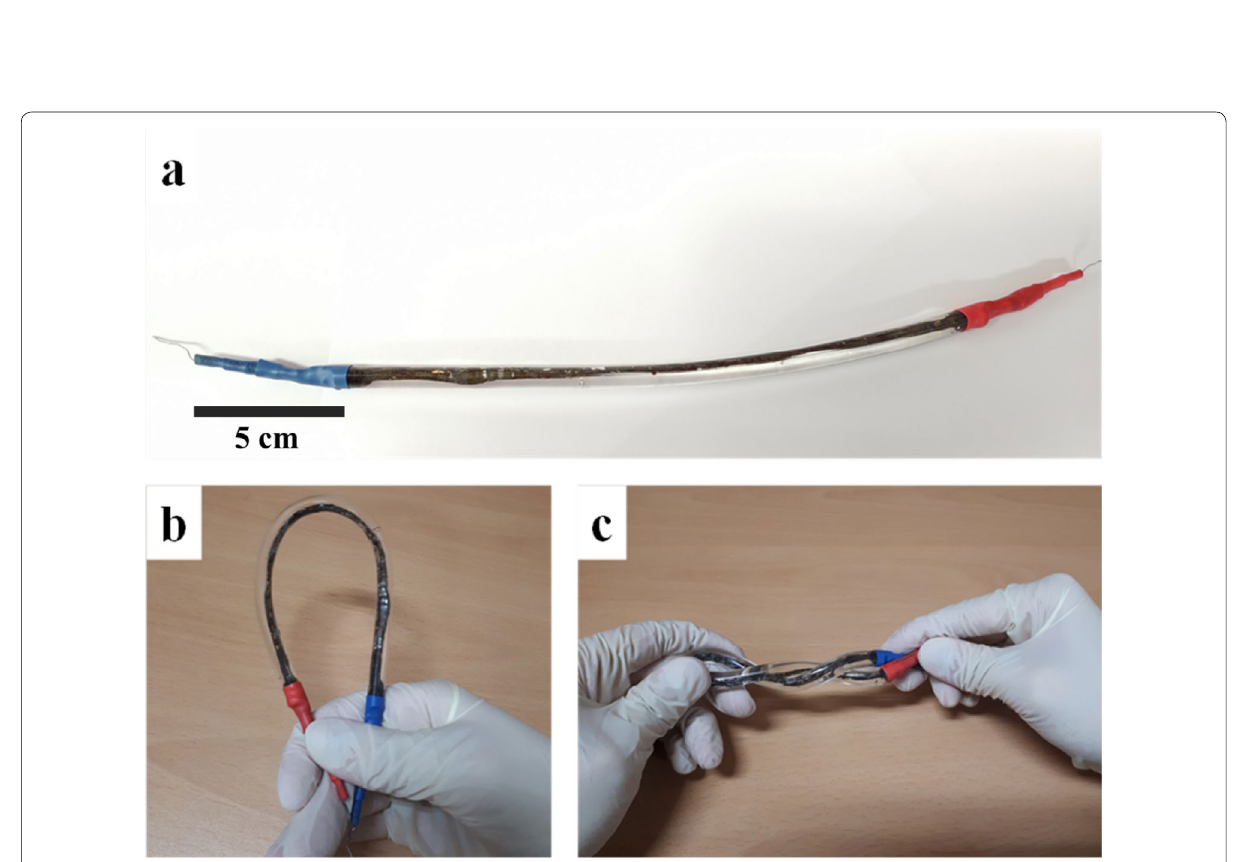
Fig. 3 Photographs of the fabricated flexible cable-shaped supercapacitor: a normal state, b bent-state, and c